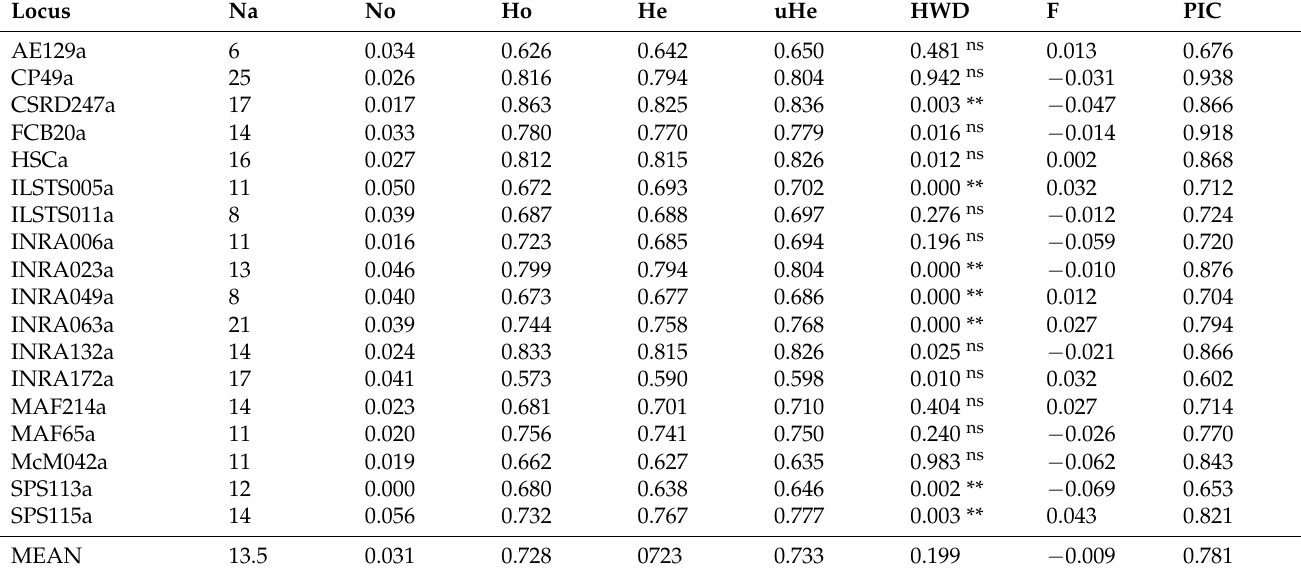
Table 3. Summary statistics of the seven sheep breeds with 291 animals genotyped in the present study. The number of alleles (Na), null allele frequency (No), observed heterozygosity (Ho), expected heterozygosity (He), unbiased expected heterozygosity (uHe), deviation from Hardy–Weinberg (HWD), p -value (ns = not significant, ** p < 0.01), inbreeding coefficient (F), and the polymorphic information content (PIC). Null allele frequency was estimated using the EM algorithm.